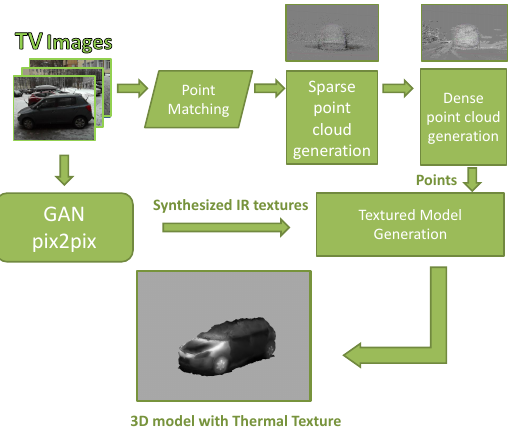
Figure 1. The proposed pipeline for generation of a 3D model with realistic infrared